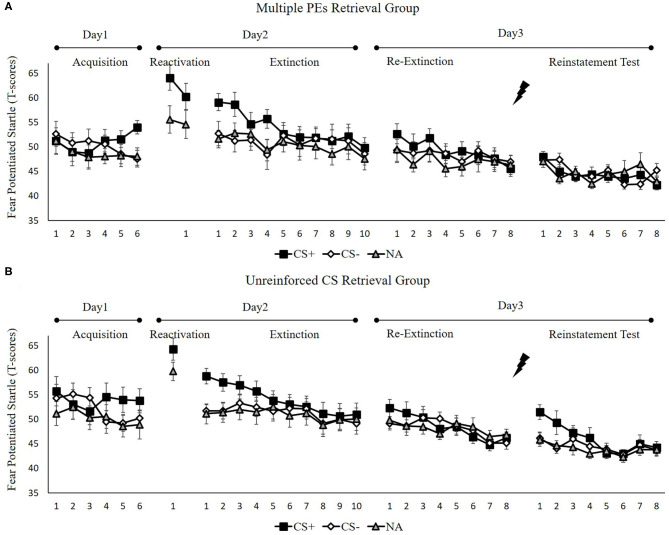
Mean startle potentiation to the fear conditioned stimulus (CS+), the control stimulus (CS–), and the noise-alone (NA) trials during acquisition, memory reactivation, extinction, re-extinction, and reinstatement test for (A) the multiple PE retrieval group (n = 17) and (B) the unreinforced CS retrieval group (n = 17). Error bars represent SEM.